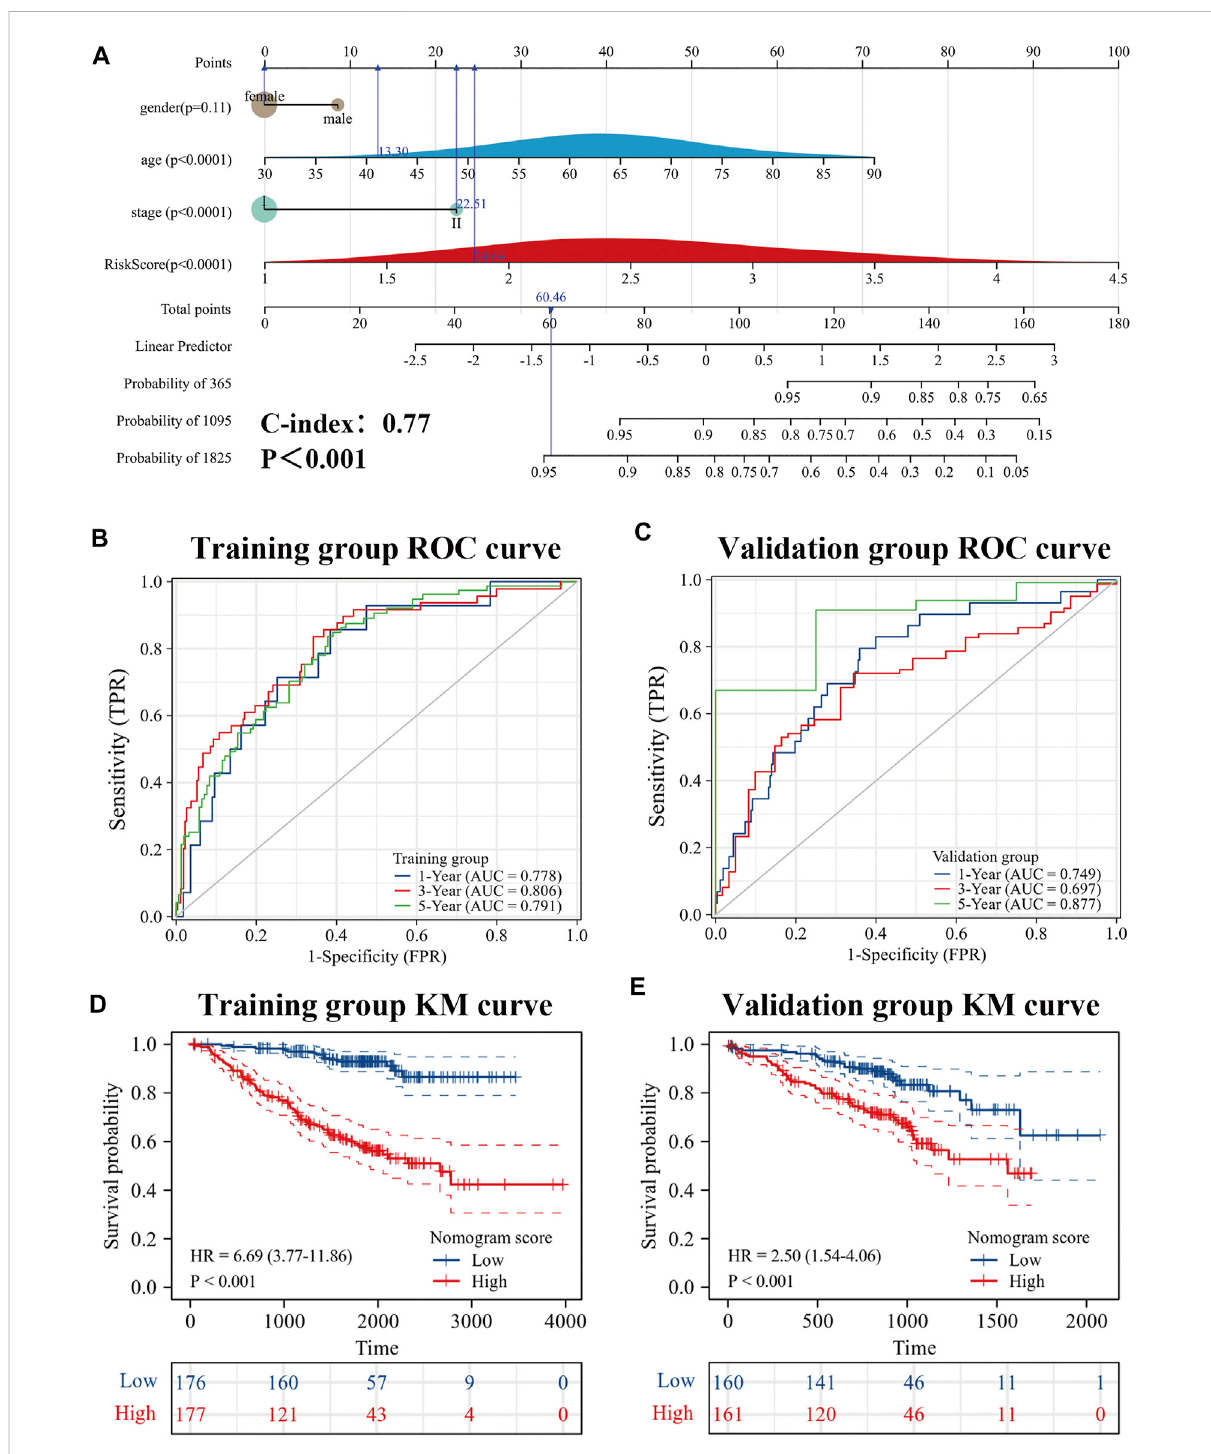
FIGURE 9 Development of Nomogram. (A) Construction of Nomogram by gender, age, pathological stage, and risk score. (B,C) 1-, 3- and 5-year ROC curves for training group and validation group; (D,E) KM curve for training group and validation group (Based on Nomogram score). KM: Kaplan-